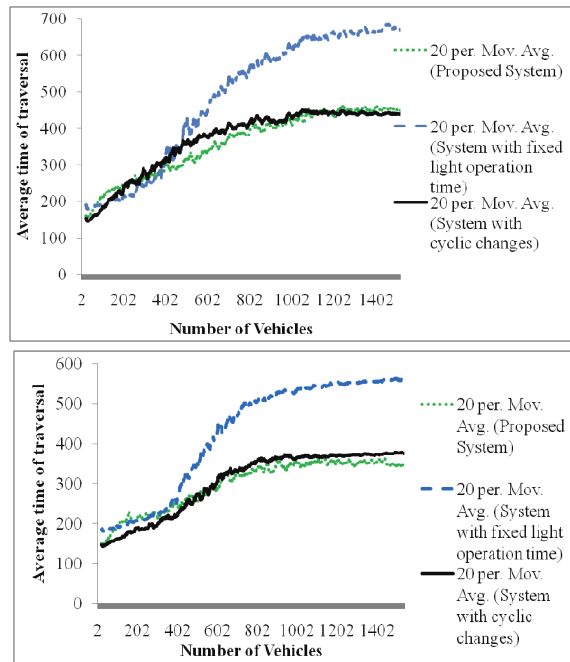
Fig. 1.Comparative analysis of traffic lights system for different number of vehicles (a) Traffic from all sides (b) Traffic from one side blocked.